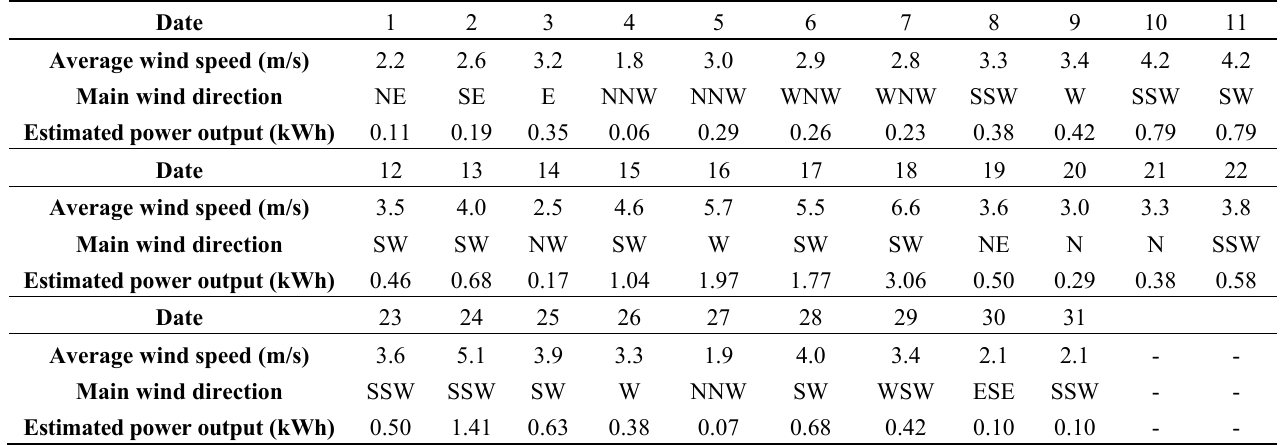
Table A3. Estimated power output per day in